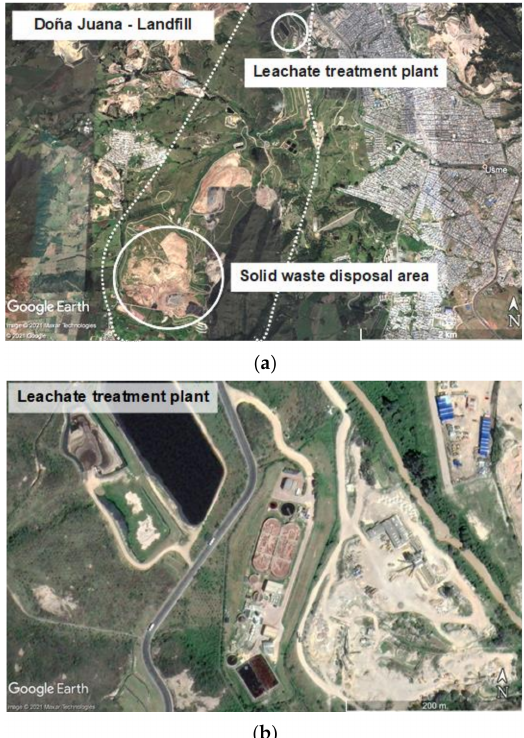
Figure 1. Location of the study area: ( a ) MSW disposal area and ( b ) leachate treatment plant (Google Earth Pro,